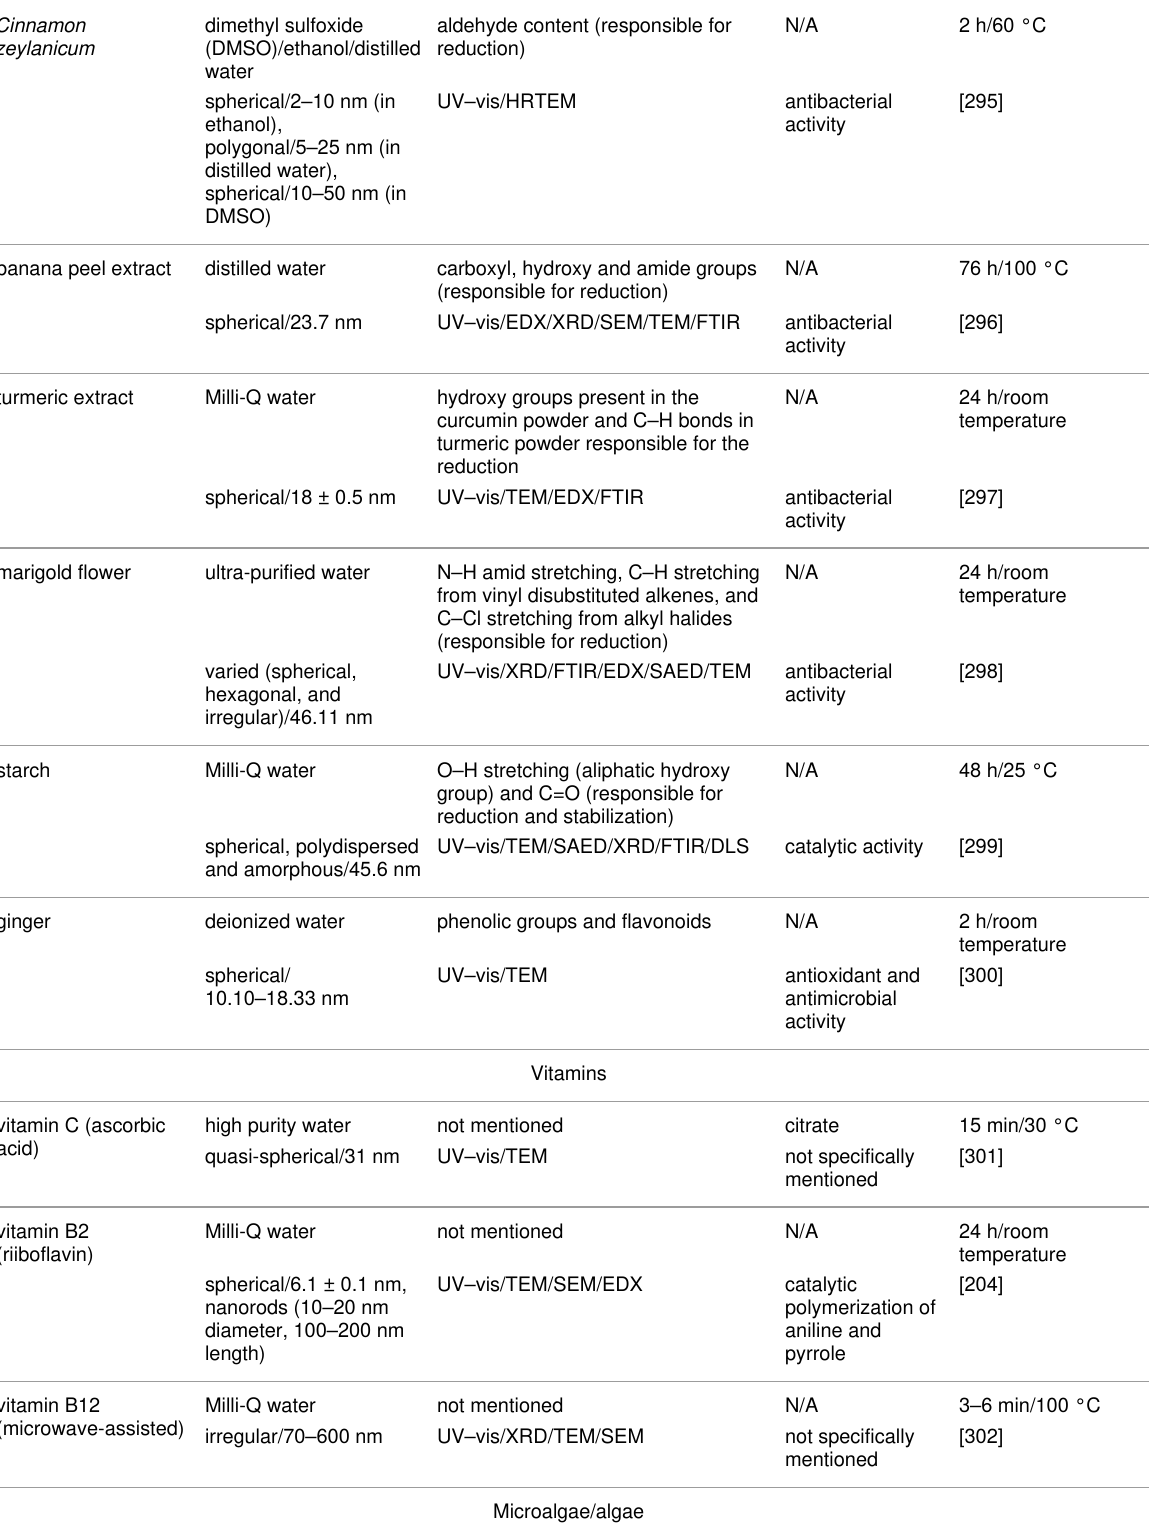
Table 2: A review of various green processes, reaction conditions, necessary functional groups, and characterization techniques used for the synthe- sis of silver nanostructures with different sizes and morphologies along with their application. (continued) Cinnamon zeylanicum